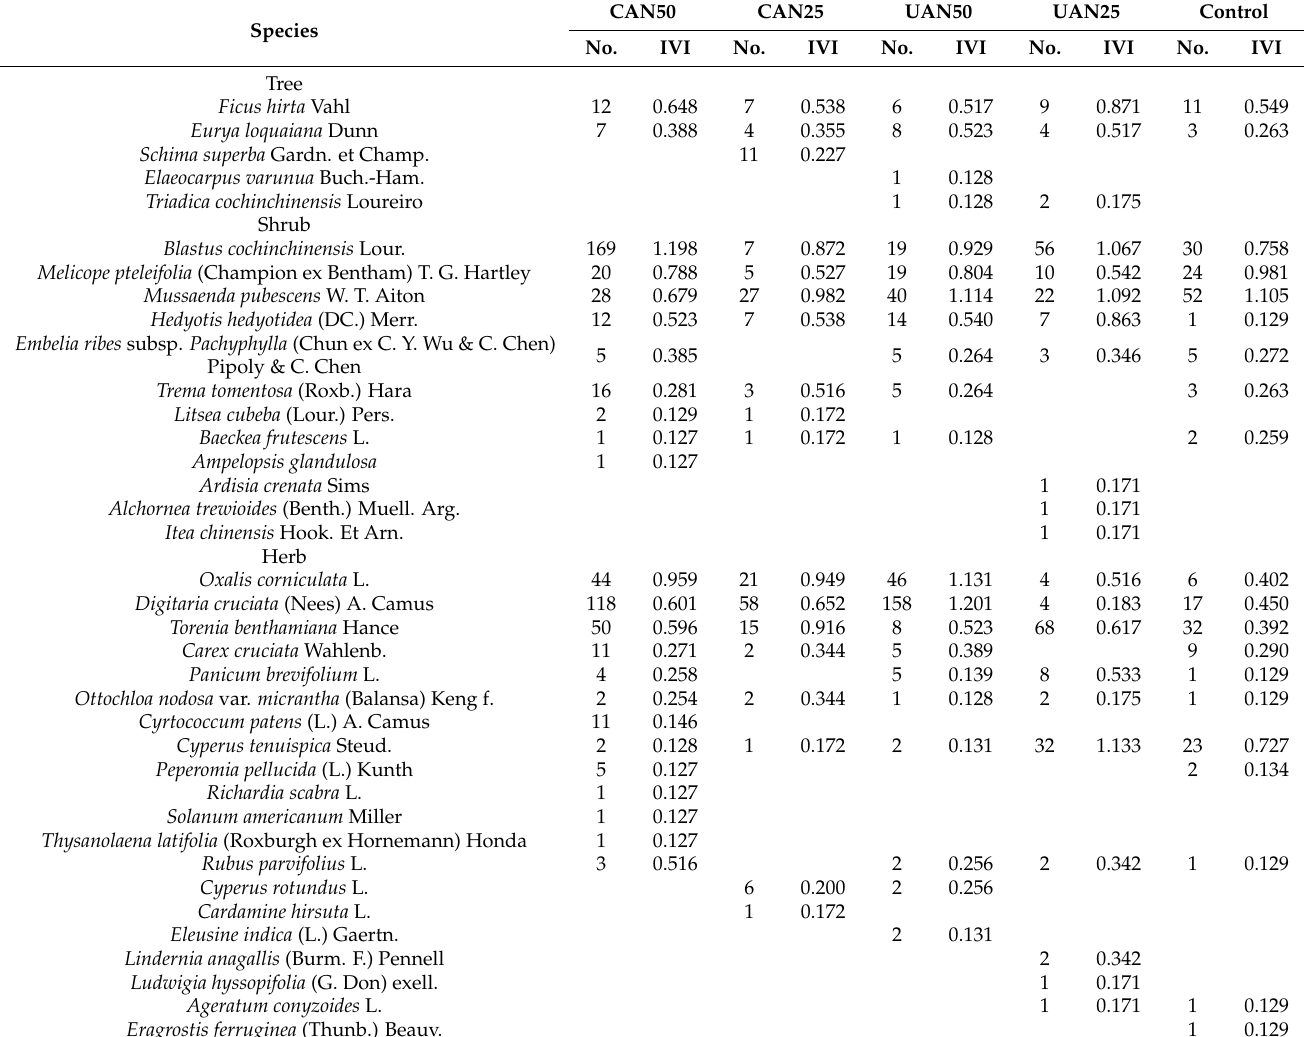
Table 1. Number (No.) of emerged seedlings per plots and the important value index (IVI) of the detected species in the soil seed bank (0–10 cm) as affected by five N addition treatments. CAN50 Species